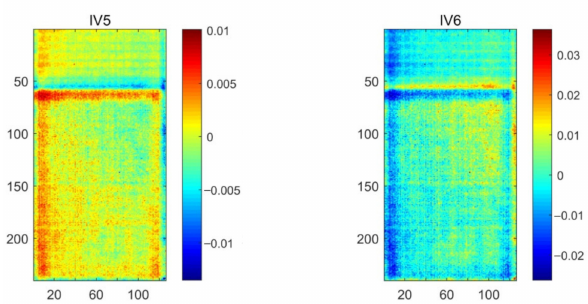
Figure 11. ISOMAP analysis results.